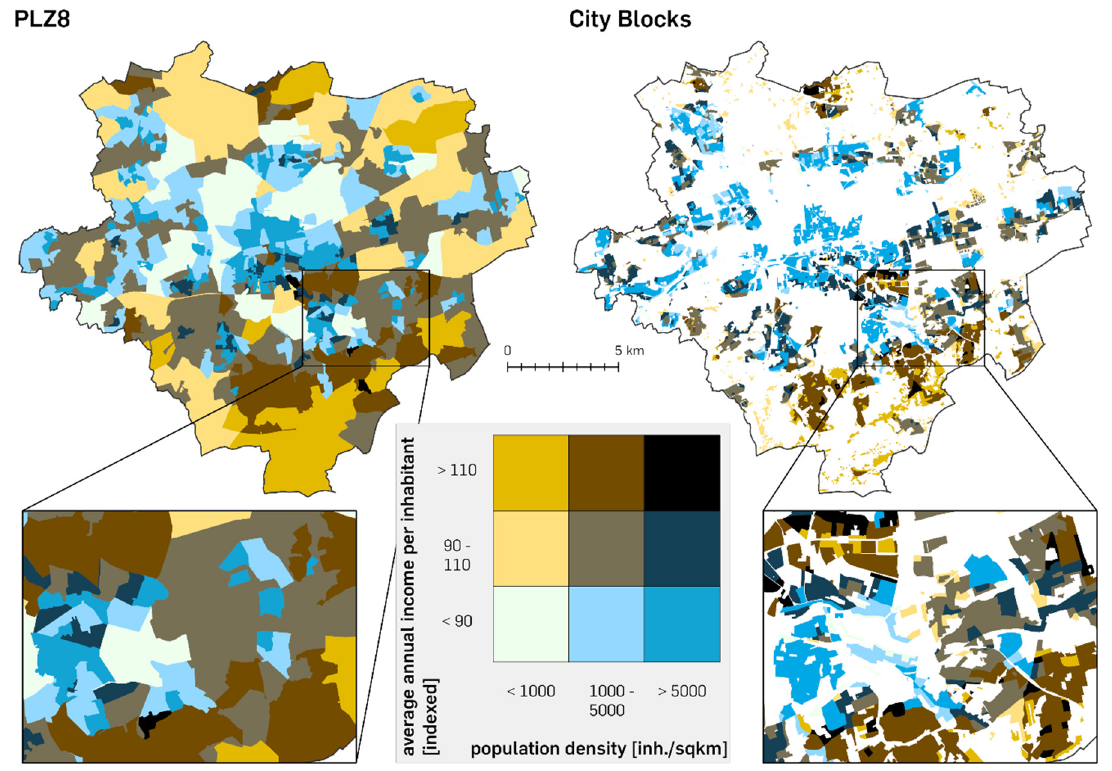
Figure 12. Disaggregated values from PLZ8 (left) to residential blocks (right) for the city of Dortmund (Data source: [22,23,25,40]).